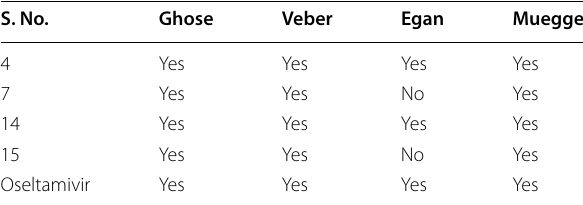
Key: Molecular weight (MW), n-octanol/water distribution coefficient (Log P), number of hydrogens bond acceptors (nHA), number of hydrogen bond donors (nHD), number of Lipinski violations (nLV)